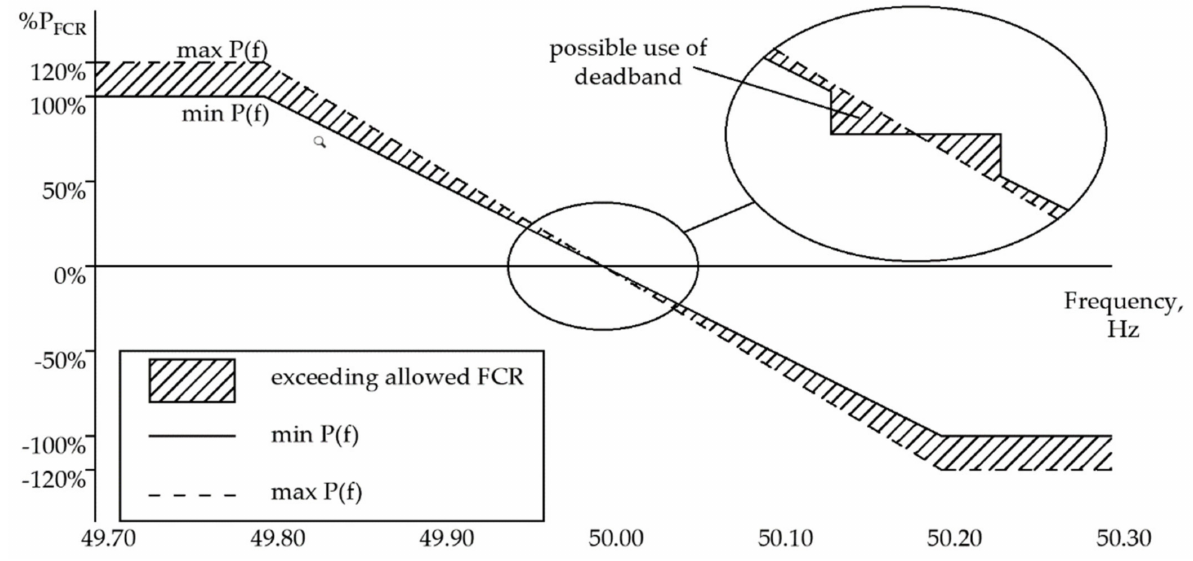
Figure 7. Exceedance range and deadband of the specified FCR